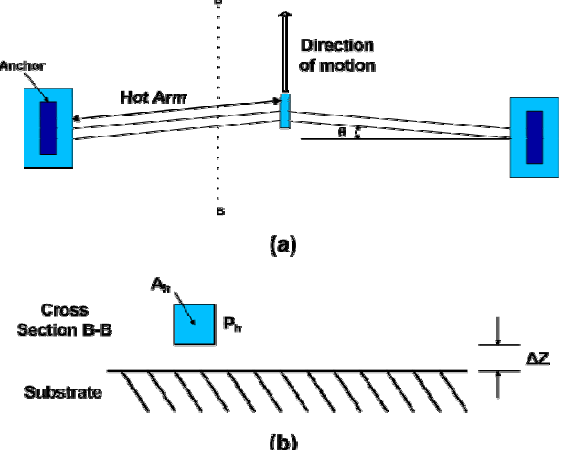
Figure 2. Schematic of a chevron-shaped thermal actuator (a) top view (b) cross section B-B